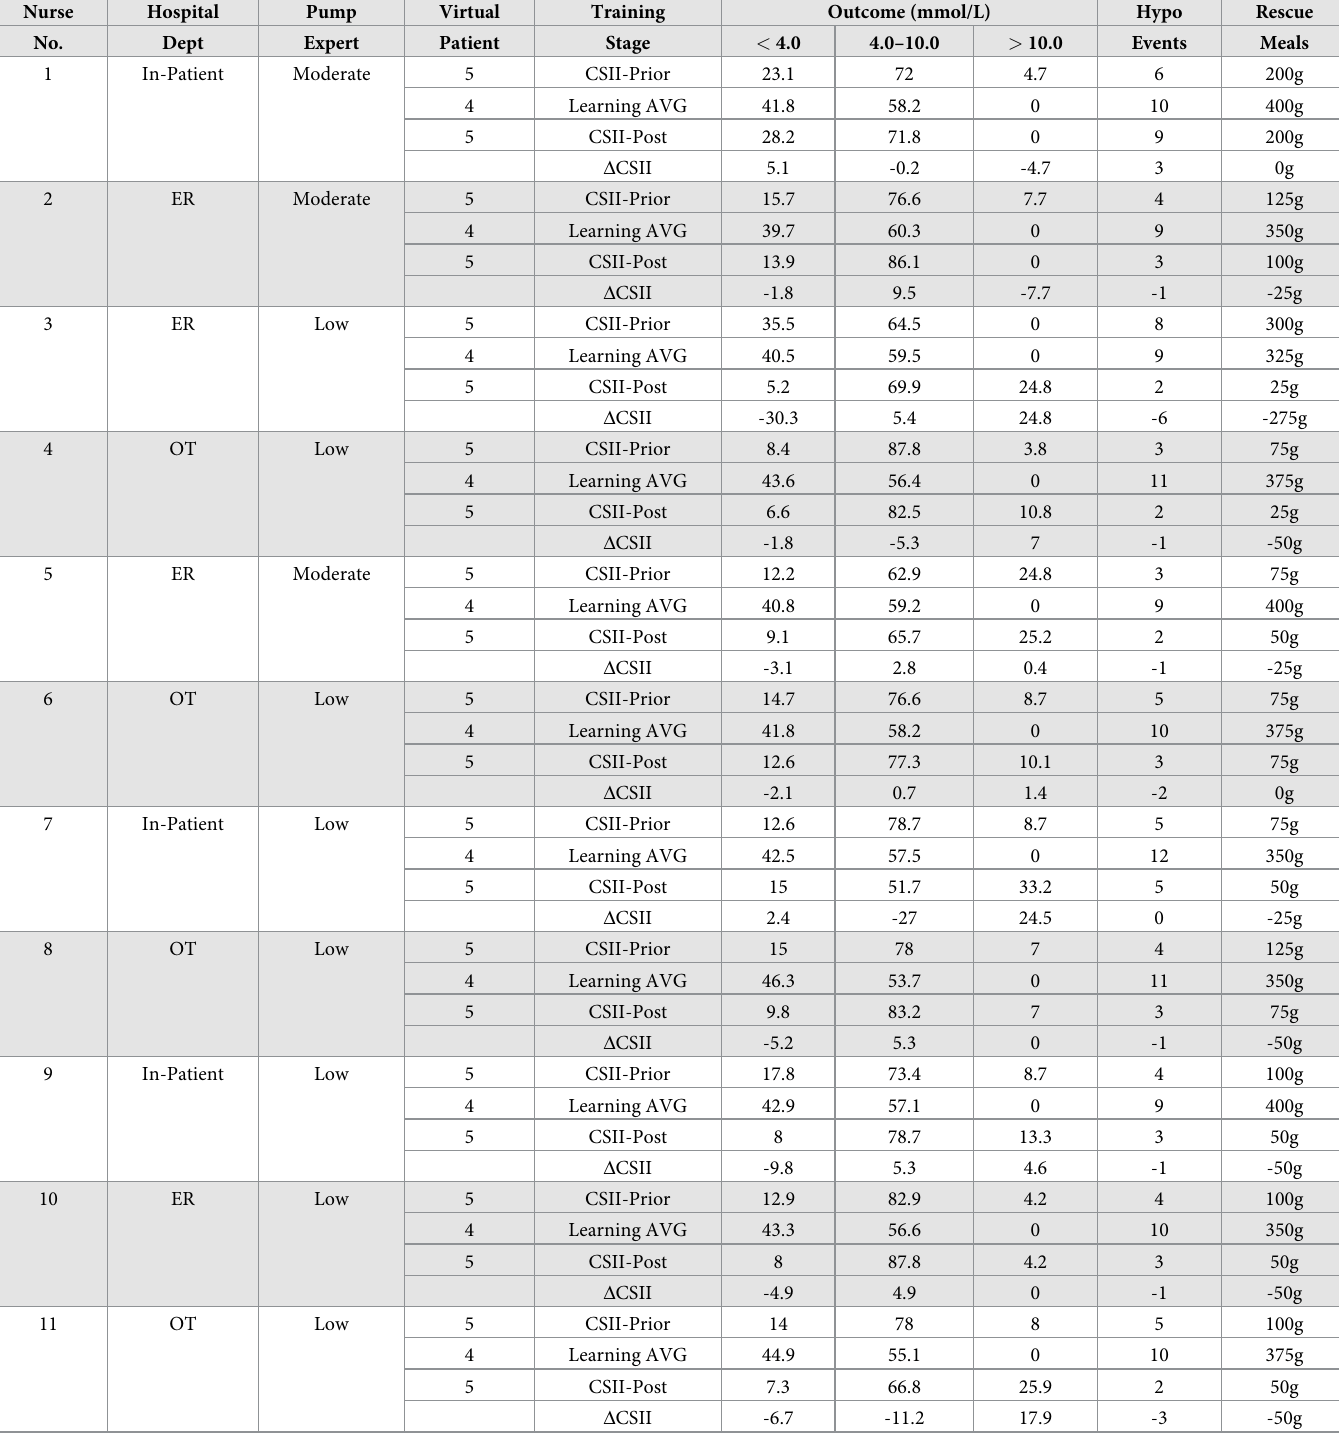
Table 2. Training session results for 13 nurses spanning training stages